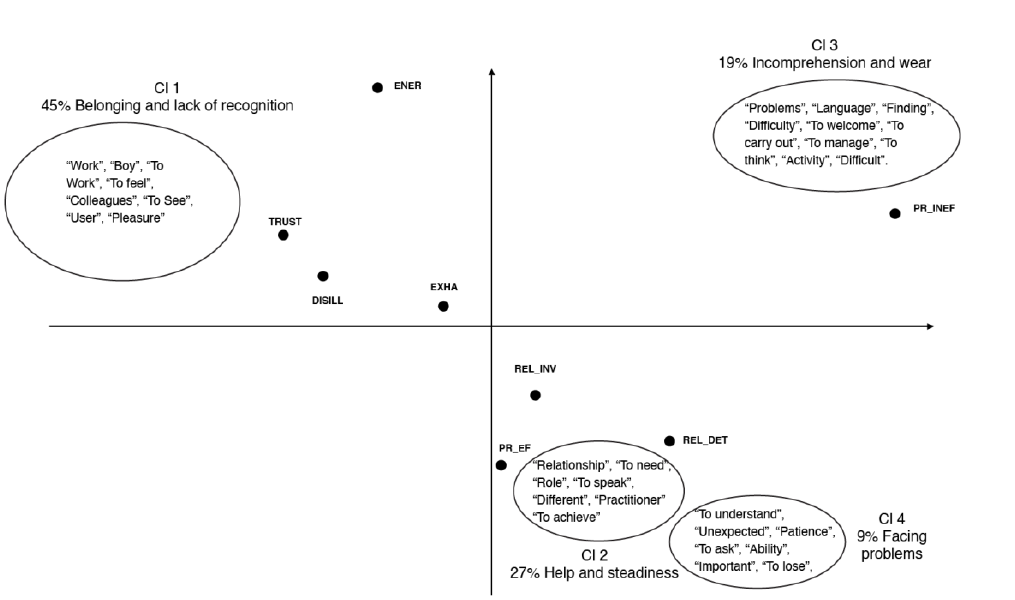
Figure 2. Representation of the clusters and descriptive variables on the factorial plane for the second-level structures. The descriptive variables are: Exhaustion (EXHA), Energy (ENER), Relational deterioration (REL_DET), Relational involvement (REL_INV), Professional inefficacy (PR_INEF), Professional efficacy (PR_EFF), Disillusion (DISILL), Trust (TRUST).